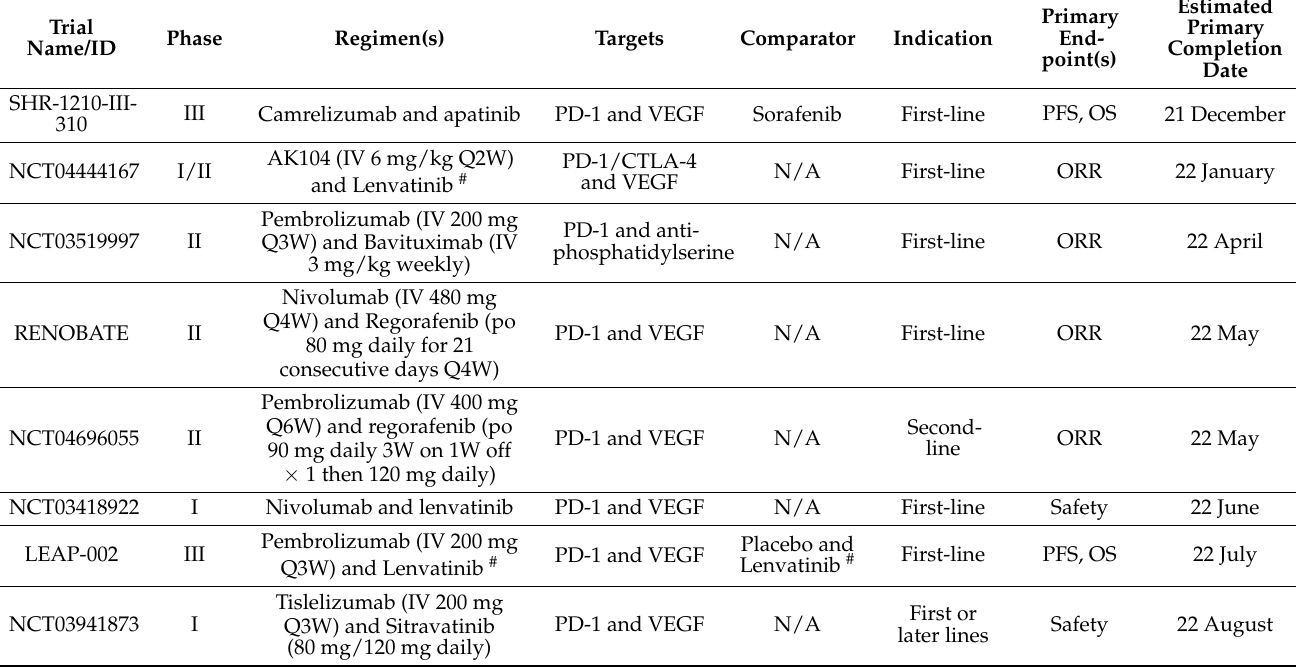
Table 3. Current ongoing key clinical trials in combination systemic treatment of advanced